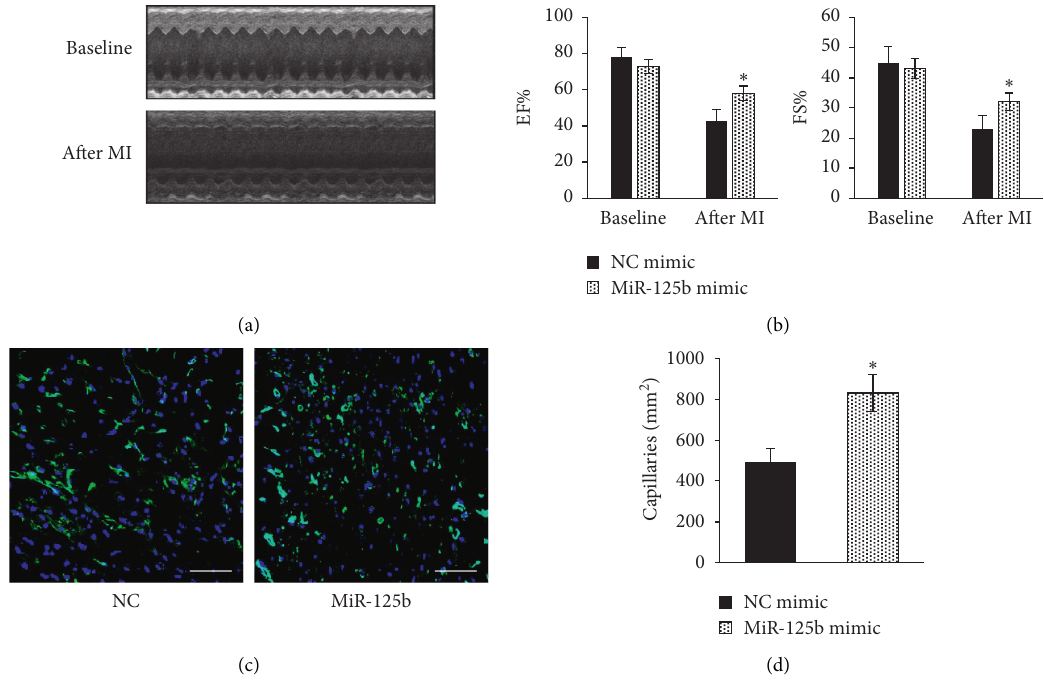
Figure 3: miR-125b overexpression enhanced the EPC-mediated neovascularization and cardiac function recovery in the ischemic hearts. The cardiac function was assessed by echocardiography at baseline and after MI (28 days). Representative (a) and quantification (b) of echocardiography analyses. EPC-mediated neovascularization in the ischemic hearts analyzed by CD31 staining (GFP) (c) and capillary density quantified (d) (scale bar � 100 μ m, ∗ p < 0 . 05 vs. NC mimic, n �